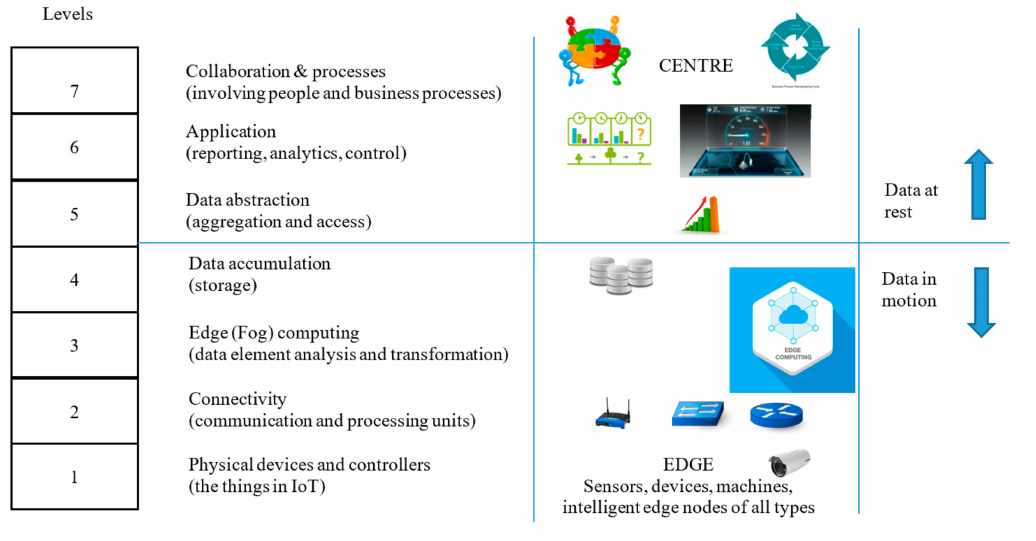
Figure 1. IoT reference